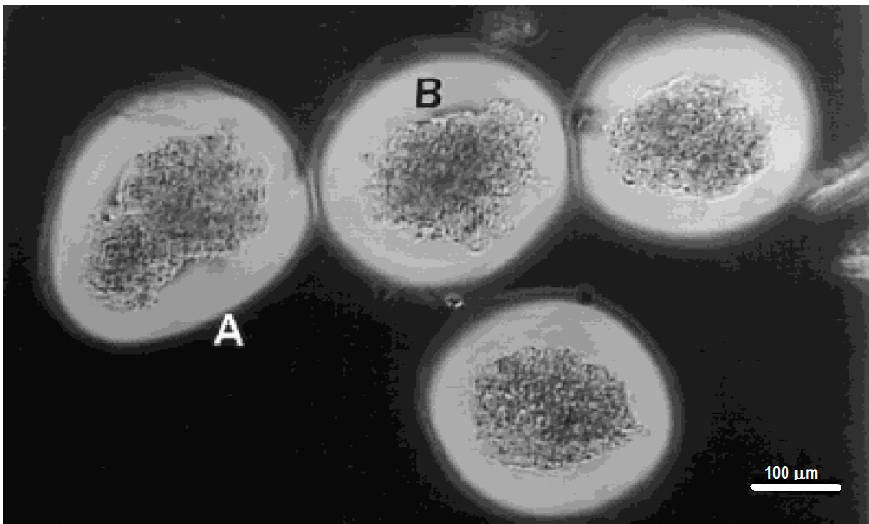
Figure 5. Porcine islet cells encapsulated with a PEG diacrylate-based hydrogel using interfacial photopolymerization. The thin, outermost zone (labeled A) was presumed to be less crosslinked, and the filamentous nature of this outer zone may be due to the incomplete crosslinking of the hydrogel at the termination of laser illumination. Because the photoinitiator was present only at the islet surface, the thicker inner zone, closer to the islets (labeled B) and thus closer to the eosin Y photoinitiator, was presumably more highly crosslinking and thus had a more dense appearance. (Reproduced and adapted with permission from [20].)